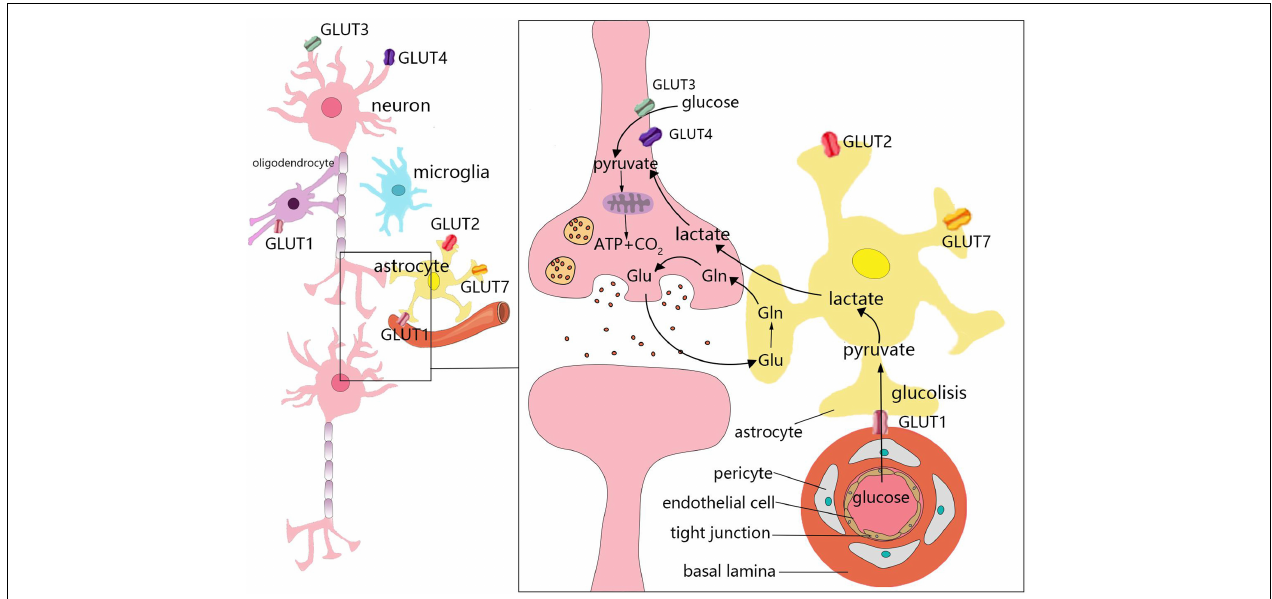
FIGURE 2 | Energy metabolism in the brain. The uptake and utilization of glucose by cells in the brain requires the neurovascular unit, which is composed of brain capillary endothelial cells, pericytes, astrocytes, oligodendrocytes, microglia, and neurons. Glucose enters cells through specific glucose transporters (GLUTs), such as GLUT1, GLUT2, and GLUT7 in astrocytes, GLUT1 in oligodendrocytes, and GLUT3 and GLUT4 in neurons. Numerous metabolic intermediates formed by glucose in the brain can also be oxidized to produce energy, such as lactate, pyruvate, and glutamate. The dynamic regulatory mechanism of lactic acid metabolism between astrocytes and neurons is known as the astrocyte–neuron lactate shuttle. Neurons release glutamate to stimulate glucose uptake by astrocytes. Astrocytes produce lactic acid by aerobic glycolysis in the cytoplasm and then transport to neurons.